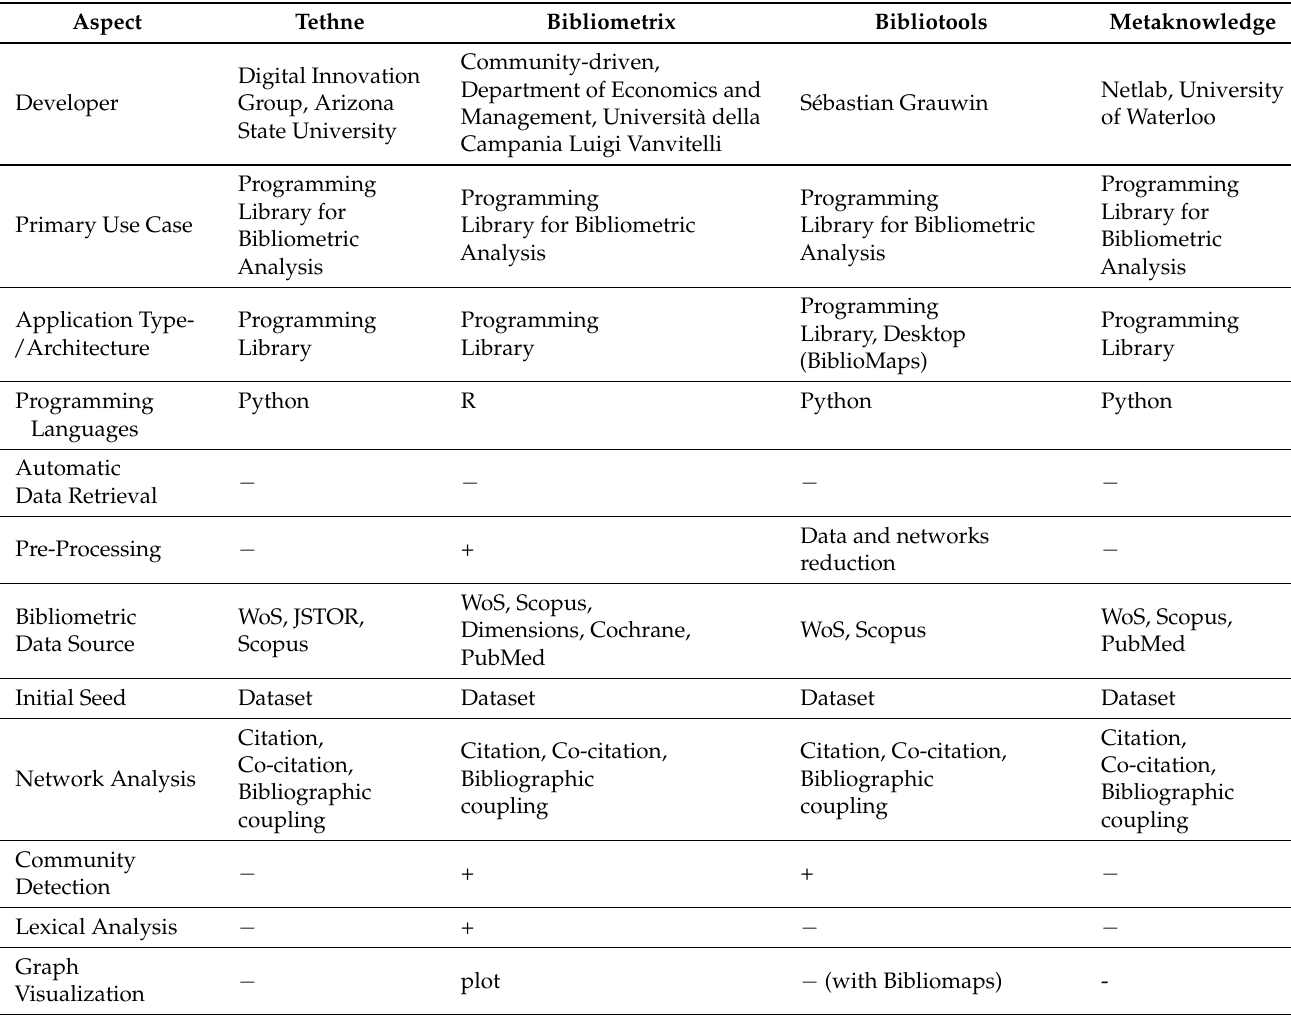
Table A2. Tool overview.